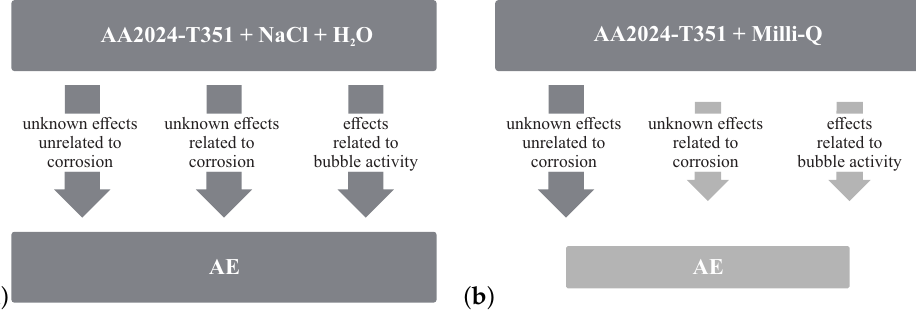
Figure 12. Classes of effects triggering AE activity on AA2024-T351: ( a ) corrosion and AE activity due to the NaCl solution and unknown contributions of different effects, ( b ) reduced corrosion and AE activity due to Milli-Q water, and consequently, reduced contributions of corrosion-related